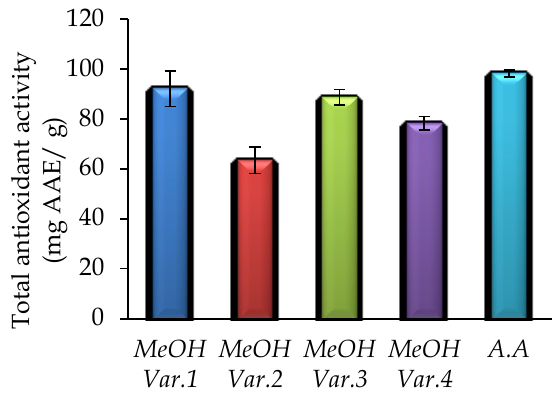
Figure 3. Total antioxidant capacity of fig flowers fruits methanolic extracts. MeOH Var.1; MeOH Var.2 : Variety 1, 2 Bakor (Fig flowers) of Bechar. MeOH Var.3; MeOH Var.4 : Variety 3, 4 Bakor of Mascara.